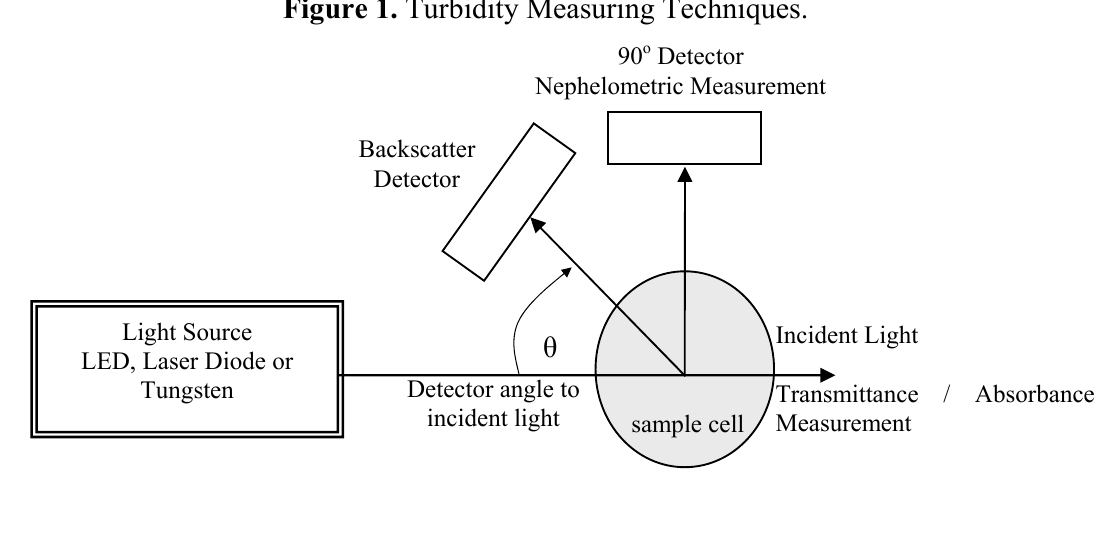
Figure 1. Turbidity Measuring